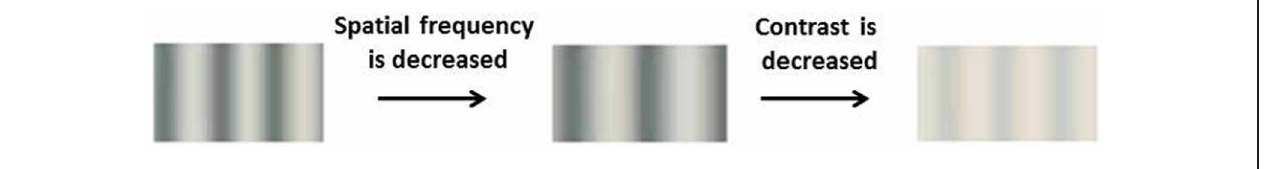
Contrast is reduced in a staircase procedure to the minimum level that can be detected by the participant. The inverse of this threshold is sensitivity. Temporal frequency is the contrast reversal of the grating